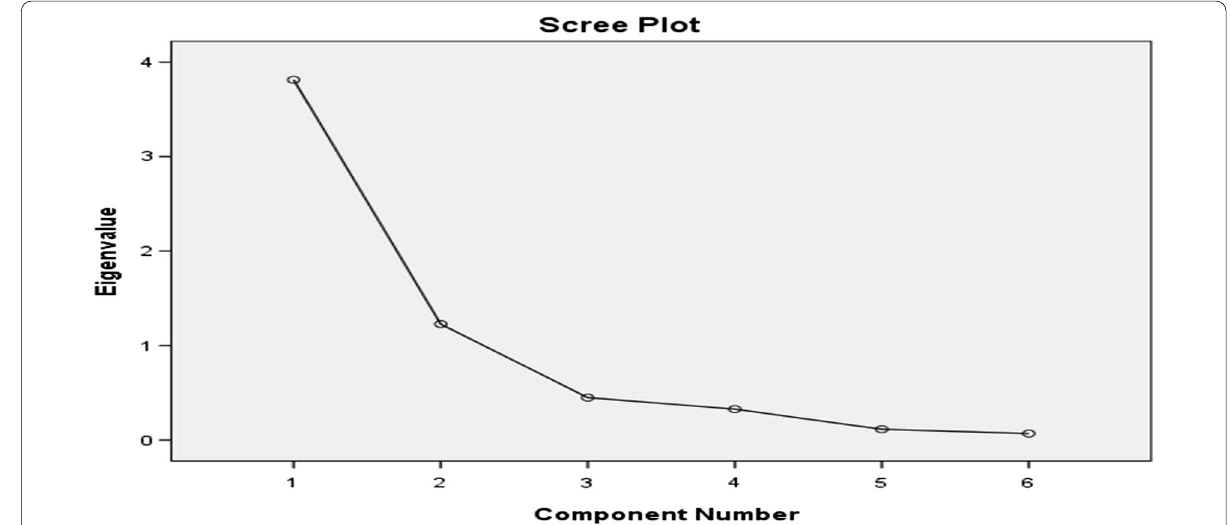
Table 4 Pearson correlation between different behavioural parameters and biochemical data Pearson